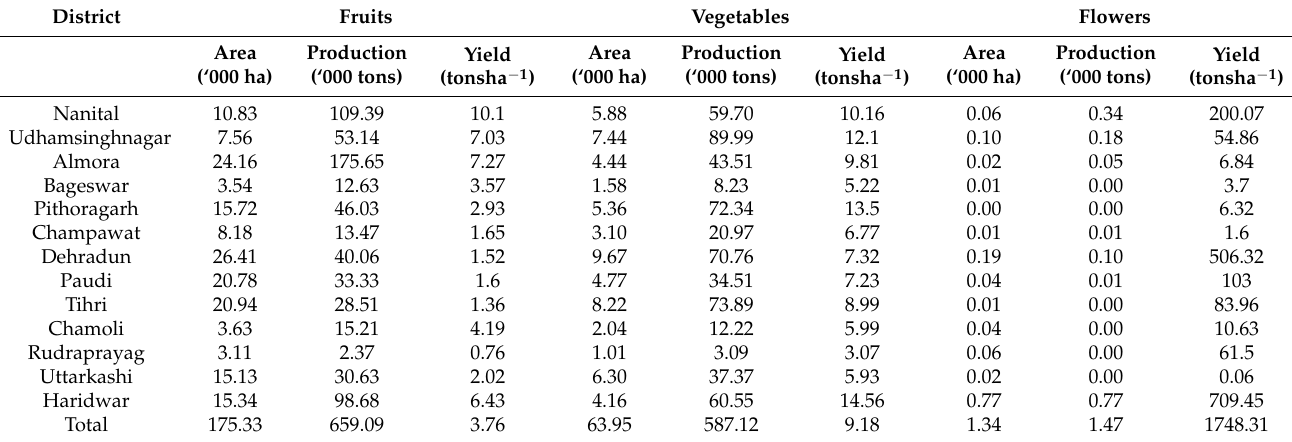
Table 2. District-wise area and production of fruits, vegetables, and flowers in Uttarakhand, 2015–2016. District Fruits